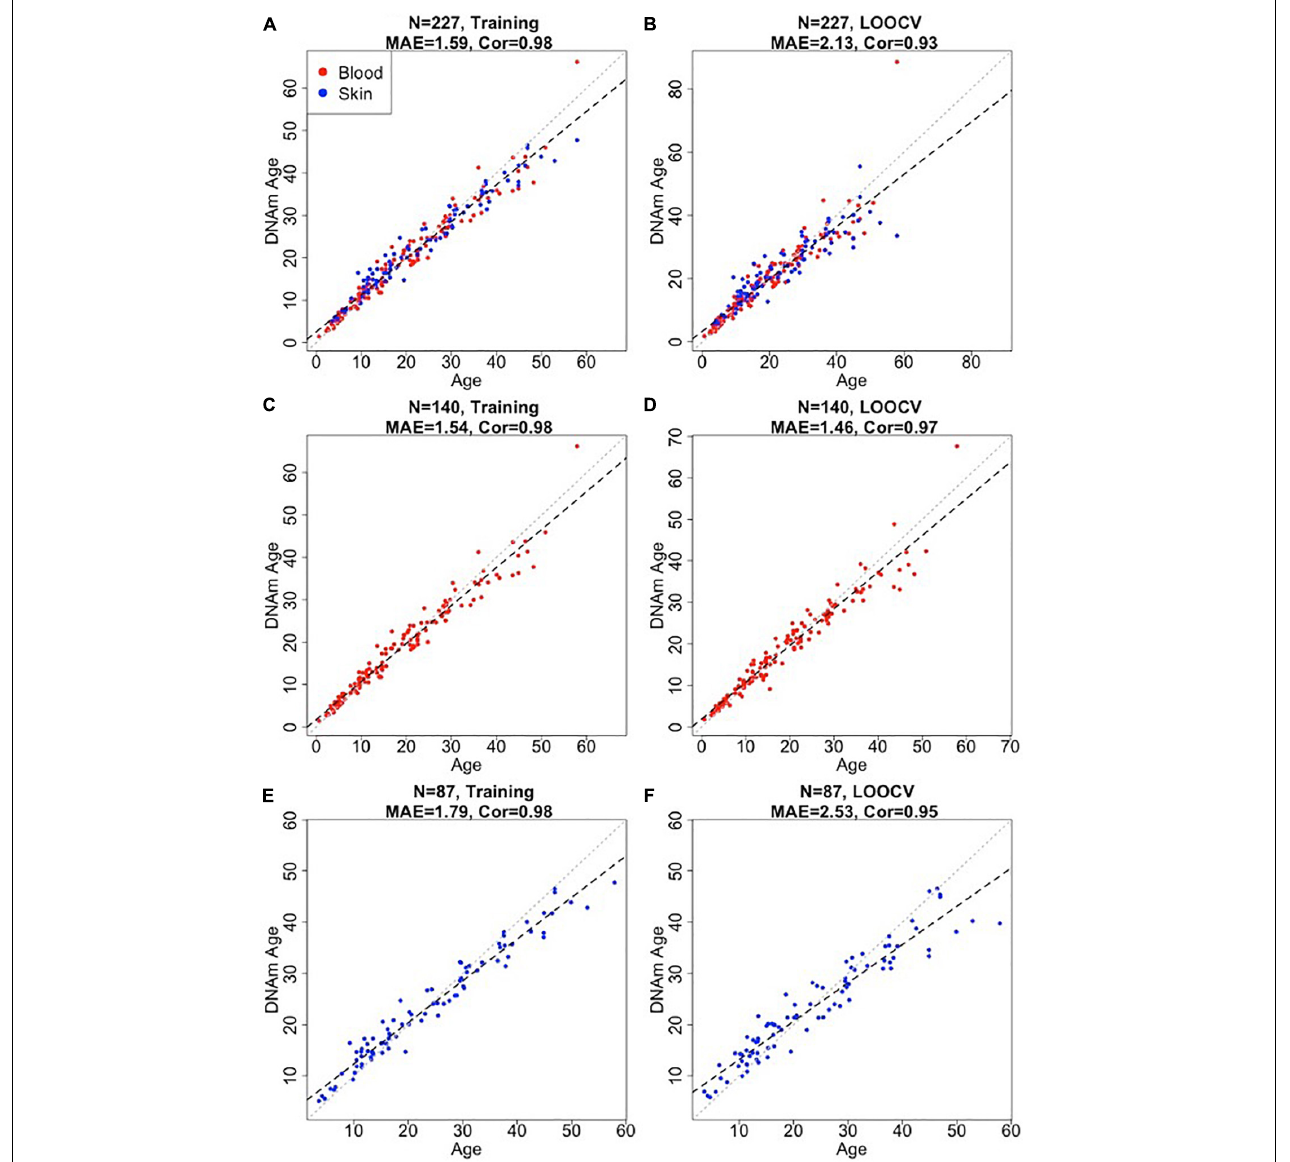
FIGURE 1 | Accuracy of epigenetic clocks for bottlenose dolphin. The panels correspond to three different clocks for bottlenose dolphins: multi tissue clock (A,B) ; blood clock (C,D) ; and skin clock (E,F) and the age estimates based on training (A,C,E) and LOOCV (B,D,F) . Dots are colored by tissue type (red = blood, blue = skin). The training set estimates (left panels) are highly biased. Each panel depicts a linear regression line (black dashed line), a diagonal line (y = x, dotted line), the sample size (N), Pearson correlation (Cor) across all samples, median absolute error (MAE) across species. Chronological age ( x -axis) and DNA methylation age estimates ( y -axis) are in units of